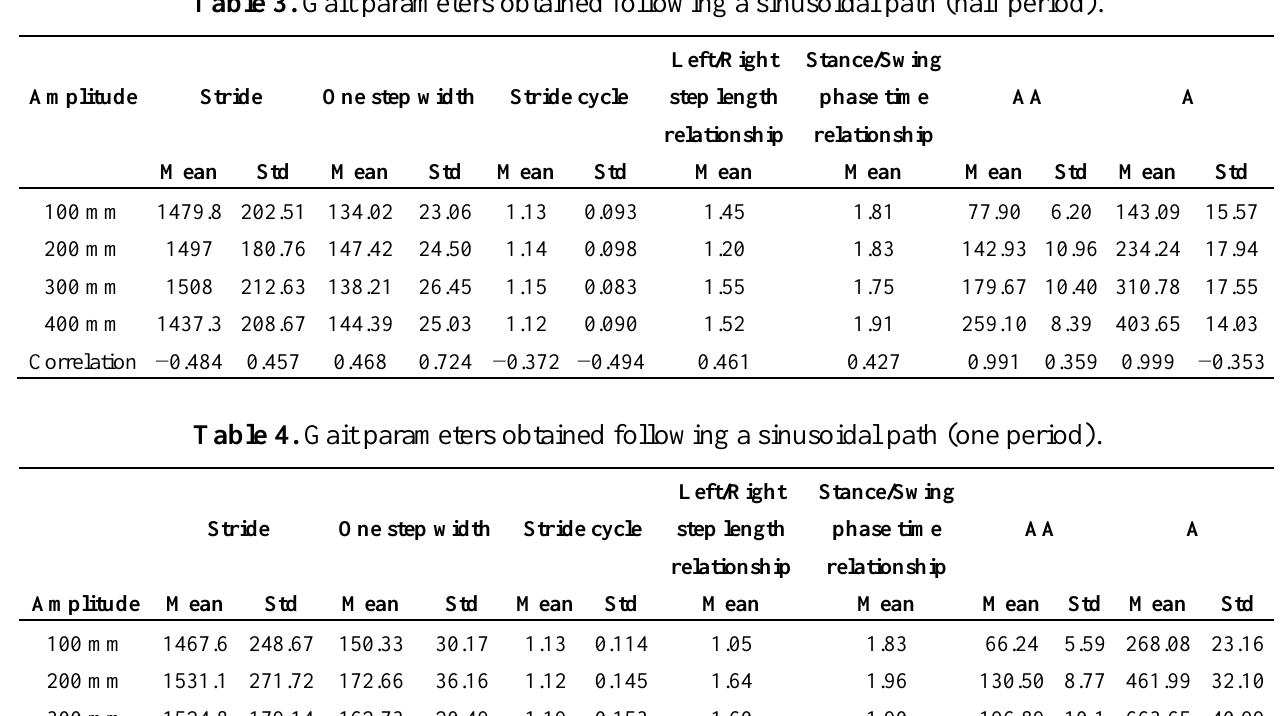
Table 3. Gait parameters obtained following a sinusoidal path (half period).